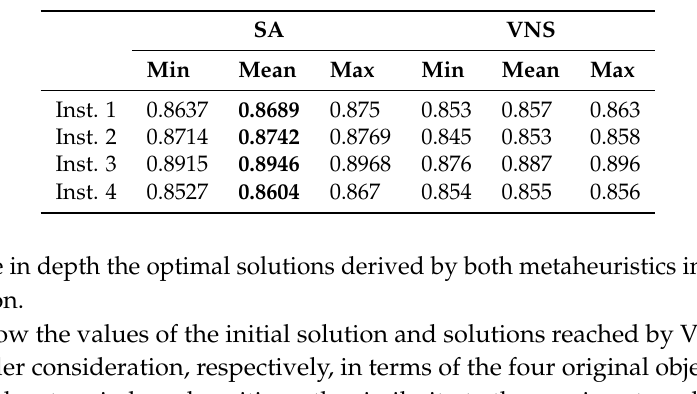
Table 2. Optimal fitness values in Phase 3 for SA and VNS.